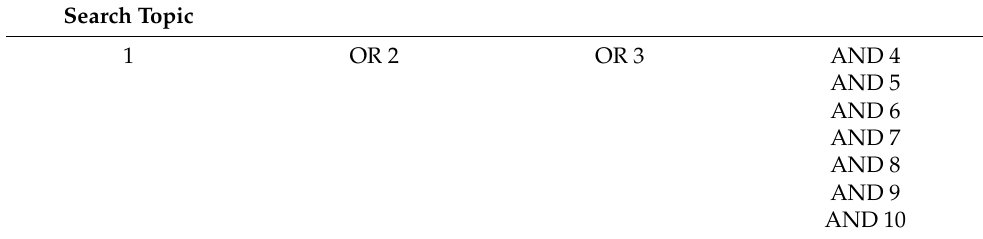
Table 1. The entire list used in the search and the combinations used in the research phase. Search